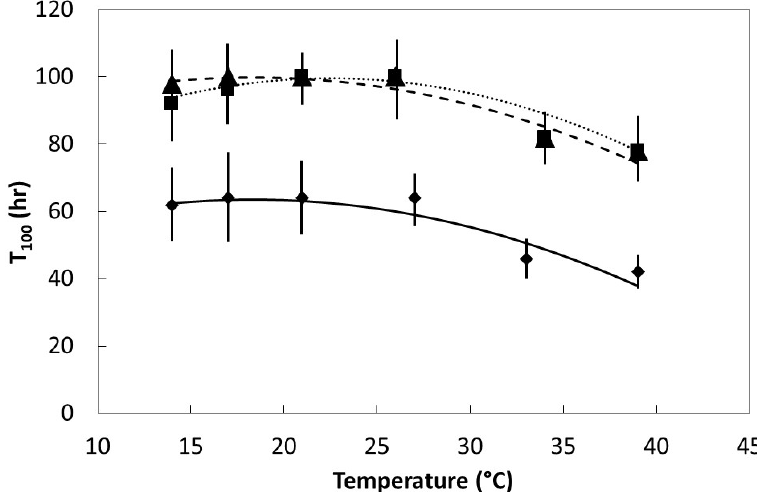
Figure 5. The influence of temperature on final time of germination for Serianthes species. Mean ± standard error, n = 6. Serianthes grandiflora (squares, dotted line), y = 59.2 + 3.6 x − 0.08 x 2 , r 2 = 0.85 ; Serianthes kanehirae (triangles, dashed line), y = 79.8 + 2.2 x − 0.06 x 2 , r 2 = 0.88 ; Serianthes nelsonii (diamonds, solid line), y = 43.8 + 2.2 x − 0.06 x 2 , r 2 = 0.88